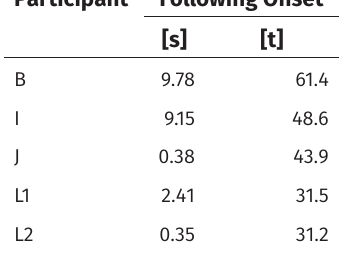
Table 4: Mean duration (ms) of the nasal murmur by participant and consonant estimated by a model with intercept and random effects